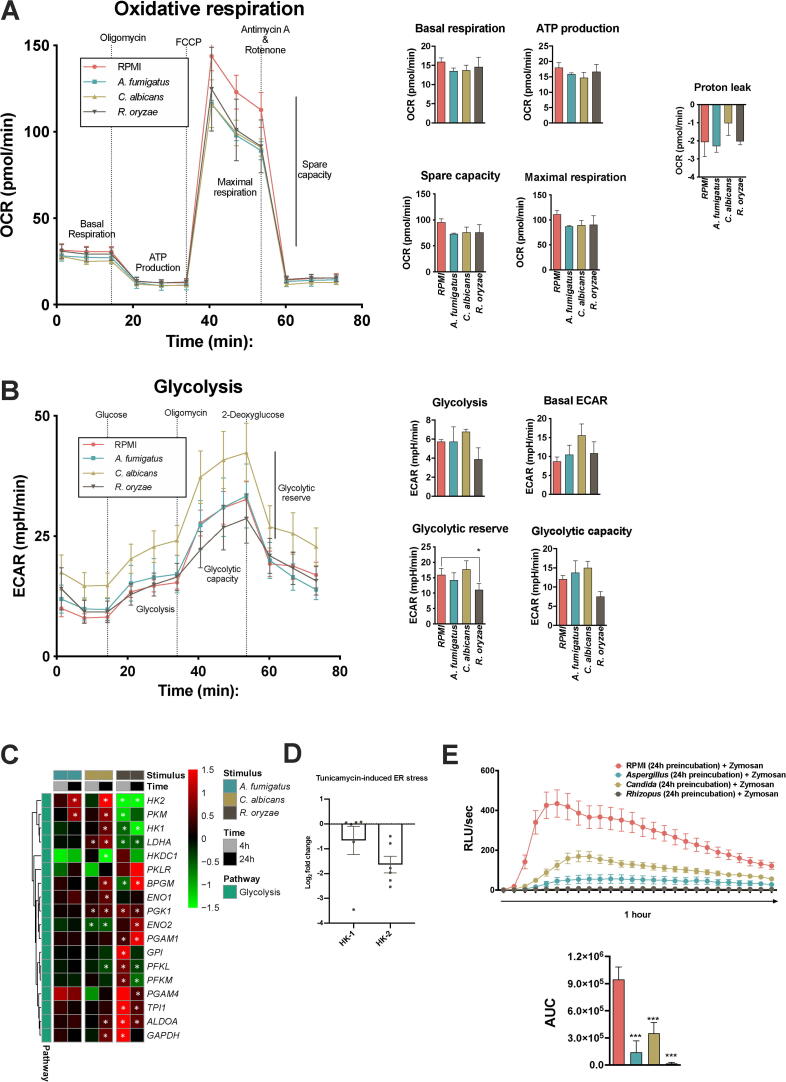
Comparative metabolic shift of host cells upon fungal stimulation: R. oryzae induces a dysfunctional glycolysis (A-B) After 12 h of incubation with A. fumigatus, C. albicans and R. oryzae, PBMCs from healthy volunteers were harvested and Oxygen Consumption Rate (OCR) (A) and Extracellular Acidification Rate (ECAR) (B) were measured by Seahorse XF e96; Basal respiration, ATP production, Maximal Respiration, Spare Respiration Capacity (SRC), Proton (H+) leak (A) and Basal ECAR, Glycolysis, Glycolysis, Glycolytic reserve (B) are represented (mean ± SEM, n = 3 donors, with 4–5 technical quadruplicates per donor, Student’s t test between R. oryzae- stimulated and unstimulated cells). (C) Heatmap of transcriptional expression of glycolytic genes extracted from the RNA-Seq dataset of PBMCs stimulated with A. fumigatus, C. albicans and R. oryzae for 4 h and 24 h compared to unstimulated cells (RPMI); the color indicates the Log2FC (Shades of red indicate upregulation, while shades of green downregulation; the white * indicates a corrected p-value of < 0.05, see legend. (D) Expression of HK1 and HK2 measured by qRT-PCR in PBMCs from healthy volunteers (n = 6 donors) under Tunicamycin-induced ER stress for 4 h, as compared with untreated cells. Log-fold changes are expressed as the ratio of gene expression, after normalization to β-actin. (E) ROS production measured in PBMCs from healthy volunteers pre-incubated with A. fumigatus, C. albicans and R. oryzae for 12 h in the presence of 10% serum and then re-stimulated with serum opsonized Zymosan. Measurements (ROS induction, RLU/sec) were taken within 1 h in intervals of 2.23 min and are reported as Area under curve (AUC) (mean ± SEM, n = 3 donors, with 4–5 technical quadruplicates per donor, One way ANOVA test with Dunnett’s multiple correction test). (For interpretation of the references to color in this figure legend, the reader is referred to the web version of this article.)